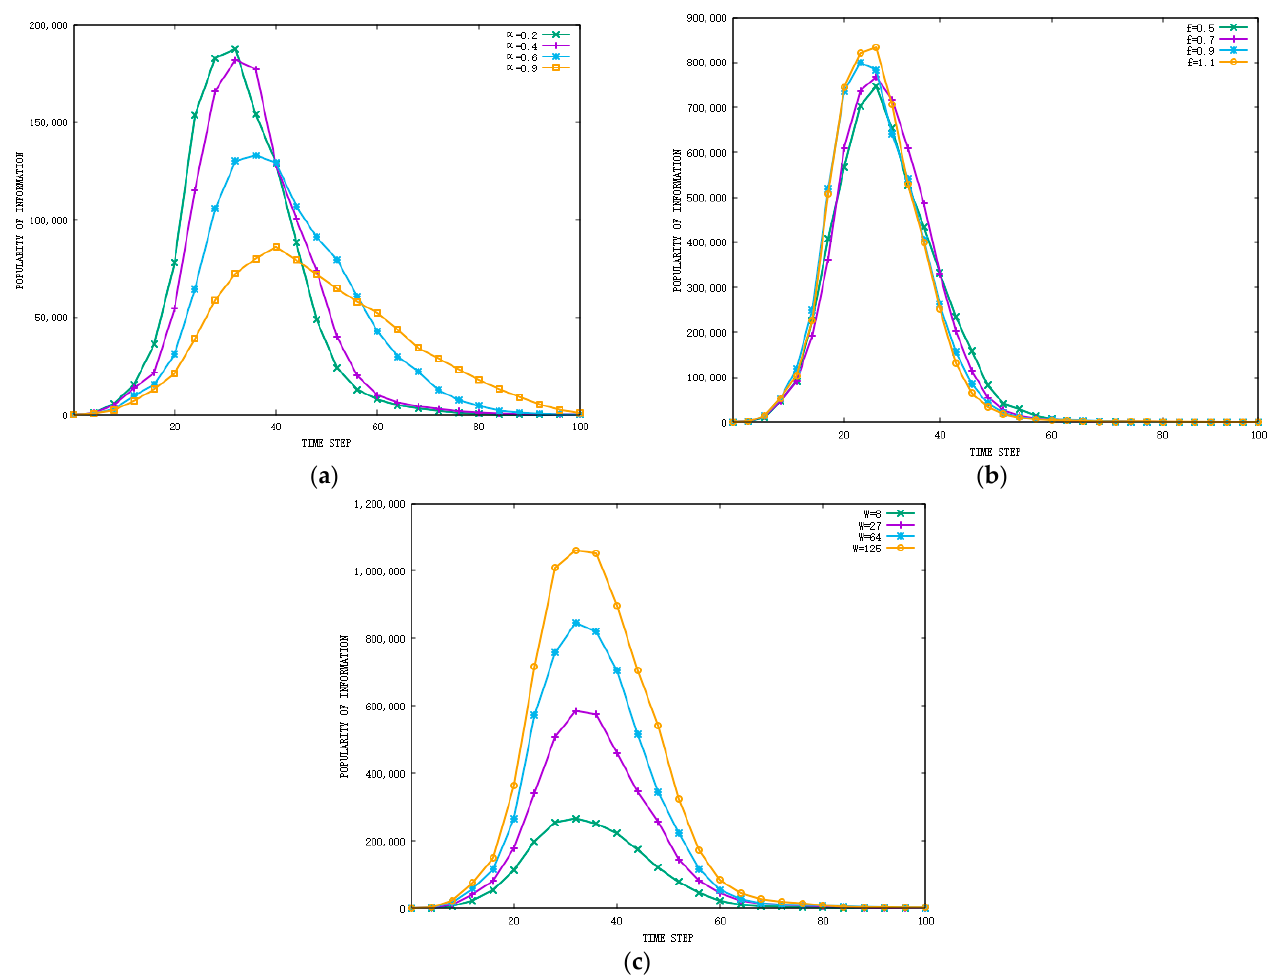
Figure 5. The impact of individual features on the popularity of the information in the Facebook dataset: ( a ) the impact of α on the popularity of the information, ( b ) the impact of 𝑓 on the popularity of the information, and ( c ) the impact of 𝑊 on the popularity of the information.